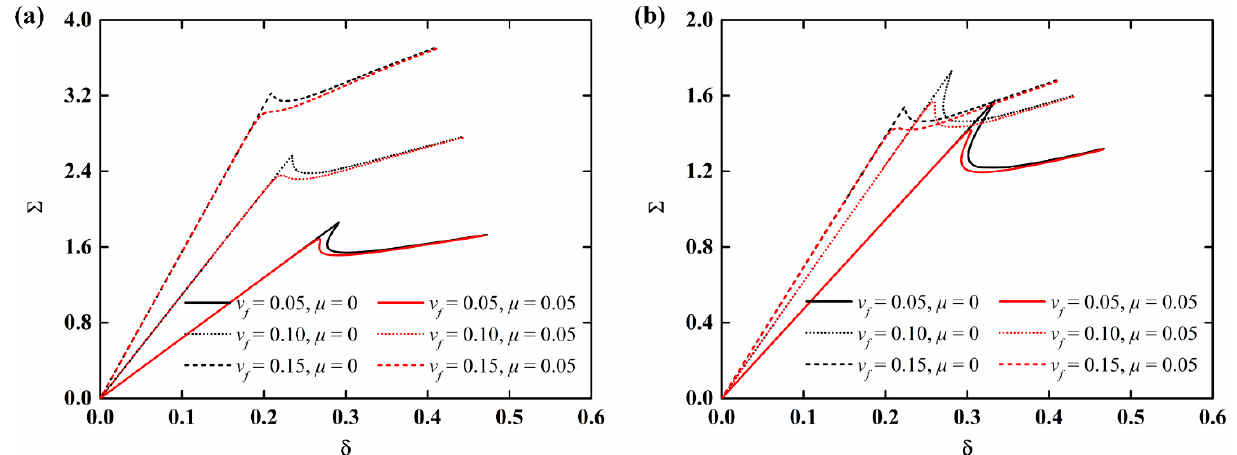
Figure 8. Load ‐ edge shortening curves of imperfect NFRC cylindrical shells for different fiber con ‐ Figure 8. Load-edge shortening curves of imperfect NFRC cylindrical shells for different fiber